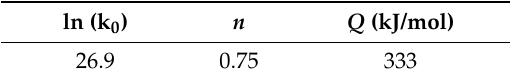
Table 3. Calculated Johnson–Mehl–Avrami (JMA) parameters for the continuous heating of TA15 titanium